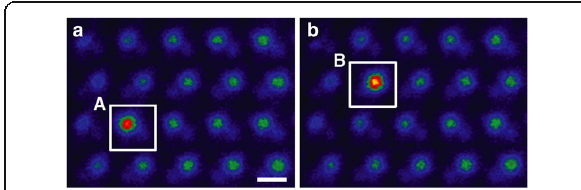
Fig. 17 Atomic-resolution STEM images of Ce hopping from column A to B in AlN. Images are averages over ( a ) 19 frames before the jump and ( b ) 19 frames after the jump. Reproduced from Ishikawa